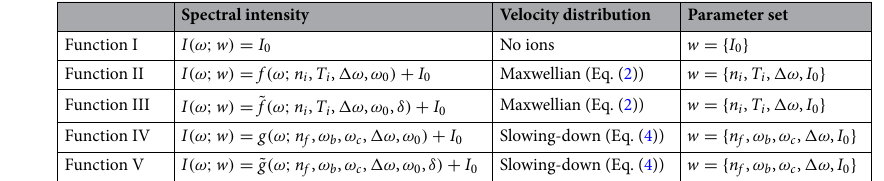
Table 1. Assumed function forms of spectral intensity and corresponding velocity distribution with their parameter sets, where ω 0 = 448.37 THz and δ = 83.977 MHz are fixed